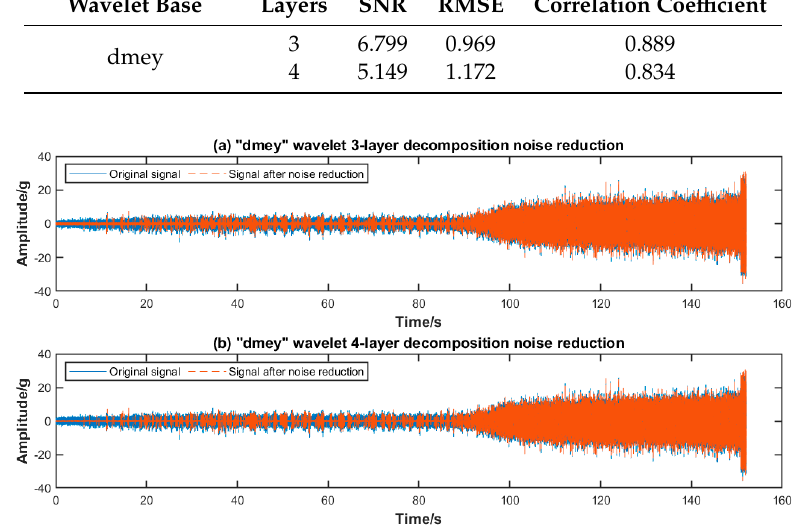
Figure 4. SNR and RMSE of noise reduction with different decomposition layers. Table 3. SNR, RMSE, and correlation coefficient after the decomposition of different layers. Wavelet Base